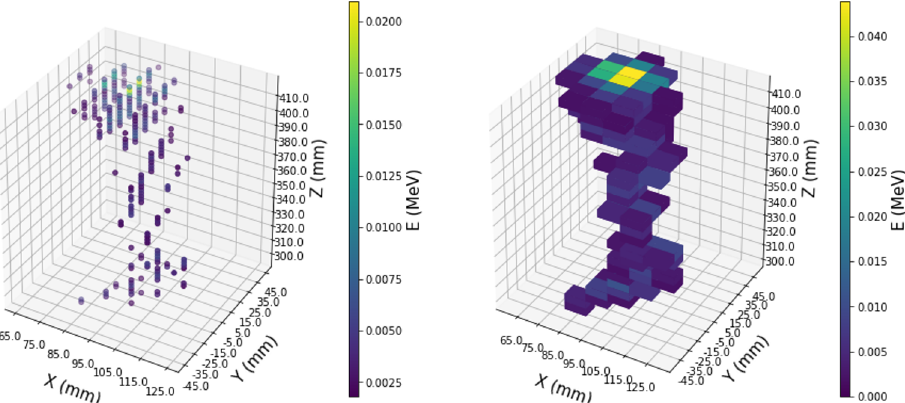
Figure 3 . Reconstructed hits (left) and voxels (right) of a background Monte Carlo event. The volume within a tight bounding box encompassing the reconstructed hits is divided into 10 × 10 × 5 mm 3 voxels to produced the voxelized